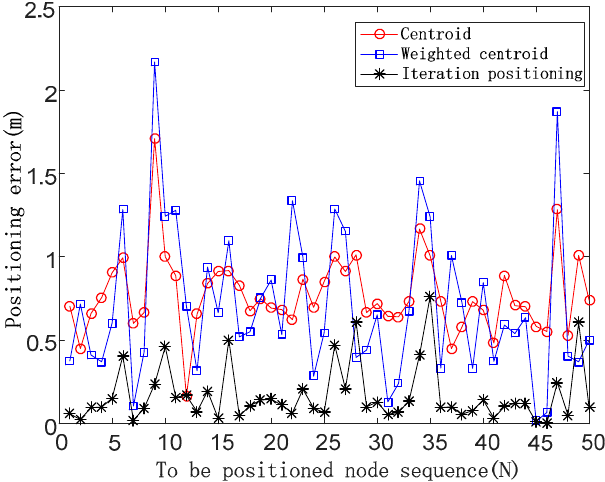
Figure 6. Positioning errors of three positioning algorithms in the case of the noise impact factor of